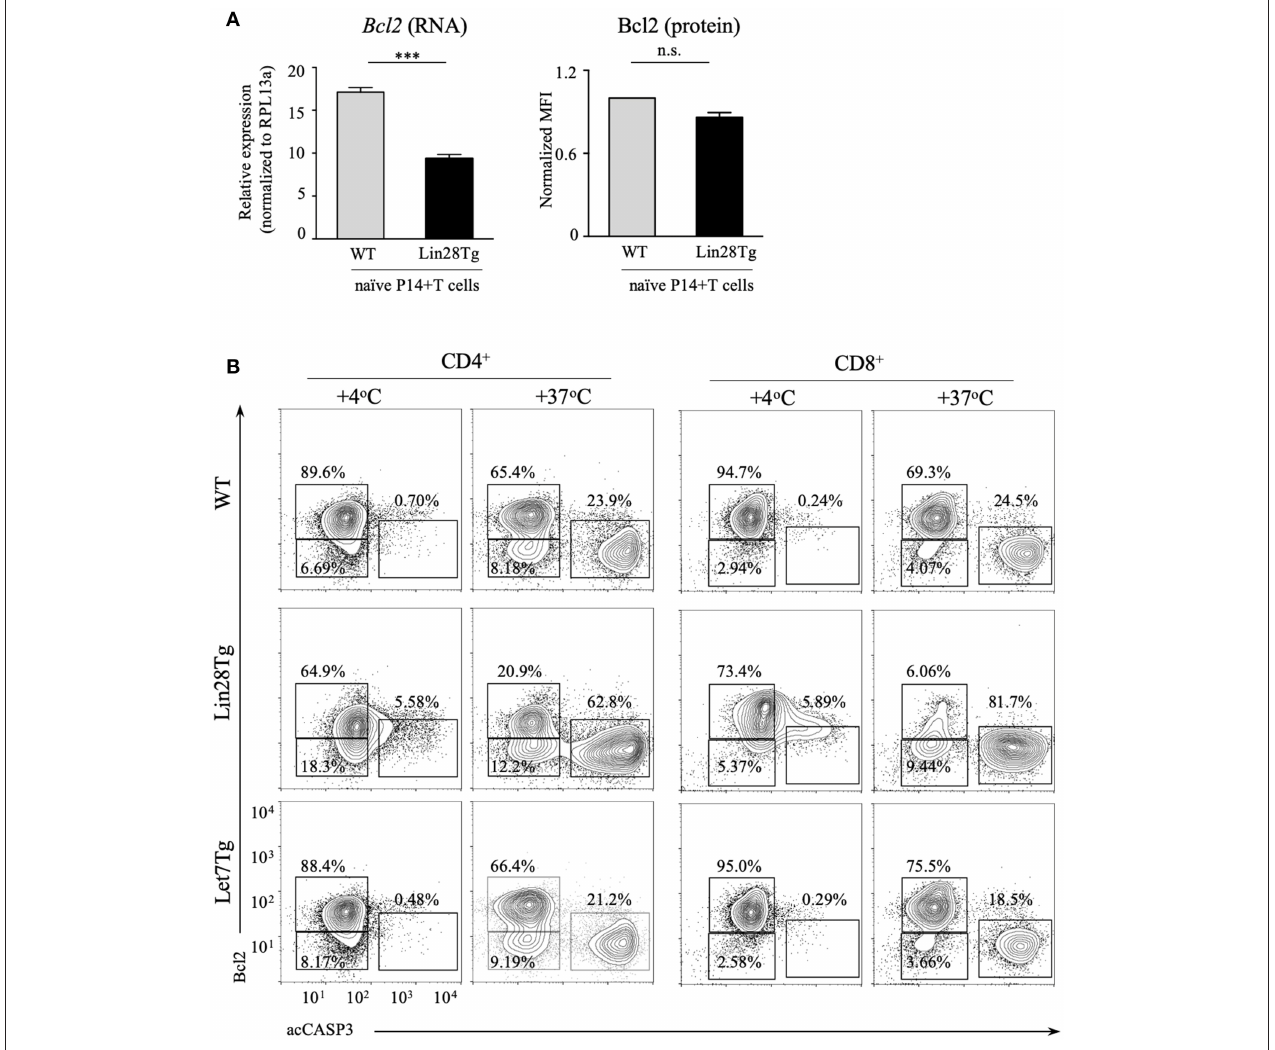
FIGURE 4 | Bcl2 expression is reduced in let-7 deficient T cells. (A) Quantitative RT-PCR analysis of Bcl2 expression, presented relative to expression of the ribosomal protein Rpl13a (left) and MFI of Bcl2 normalized to wild type (right) in CD8T cells from lymph nodes of P14 + Rag2KO wild type and P14 + Lin28TgRag2KO mice. Data are displayed as mean ± SEM of technical triplicates (B) Intracellular staining for Bcl2 and active Caspase-3 in CD4 and CD8 lymph node T cells from wild type, Lin28Tg and Let7Tg mice, cultured for 18h in media. Data are representative of three independent experiments (A) and two (A) and three (B) independent staining experiments; n.s., not significant ( p > 0.05), *** p <